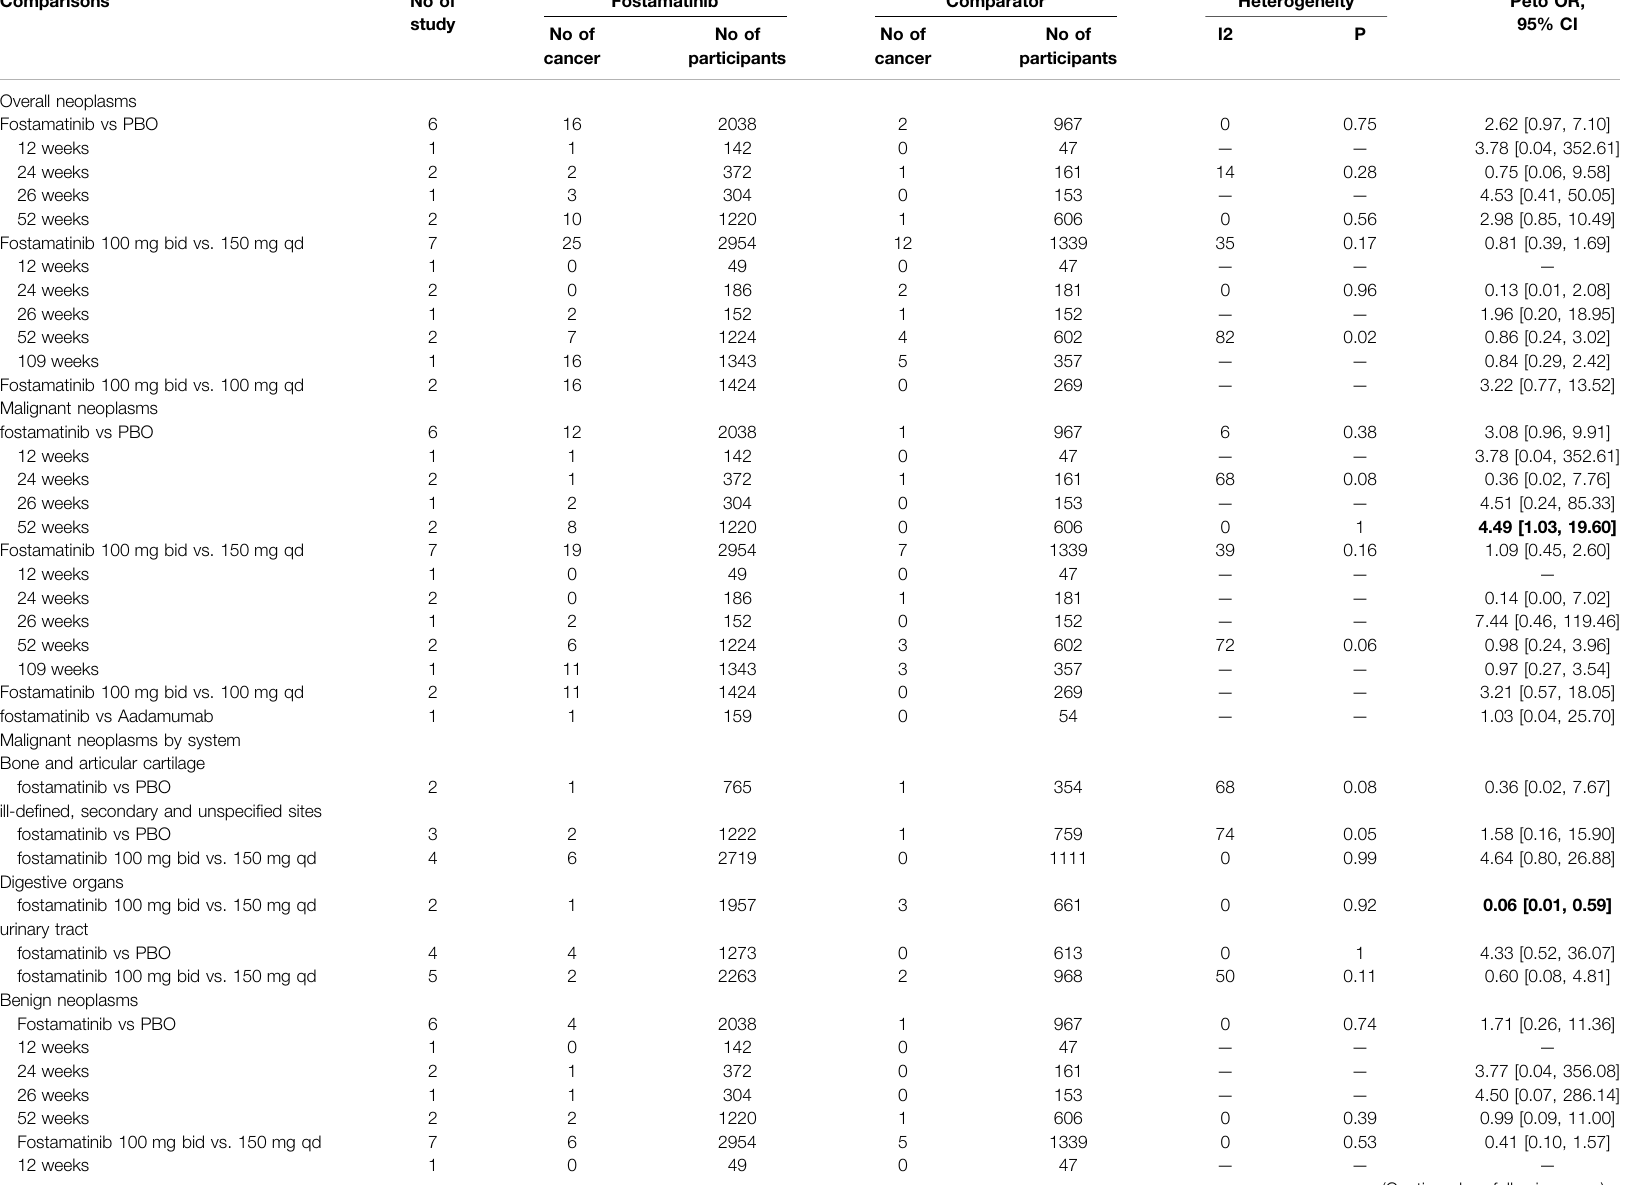
TABLE 2 | Pooled data of neoplasms in RA patients. Comparisons